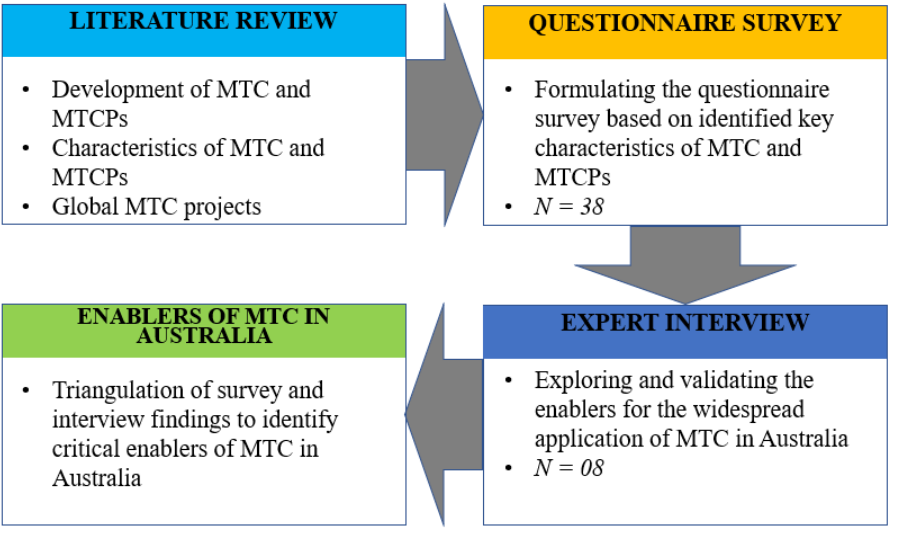
Figure 1. The key research steps used in the study.